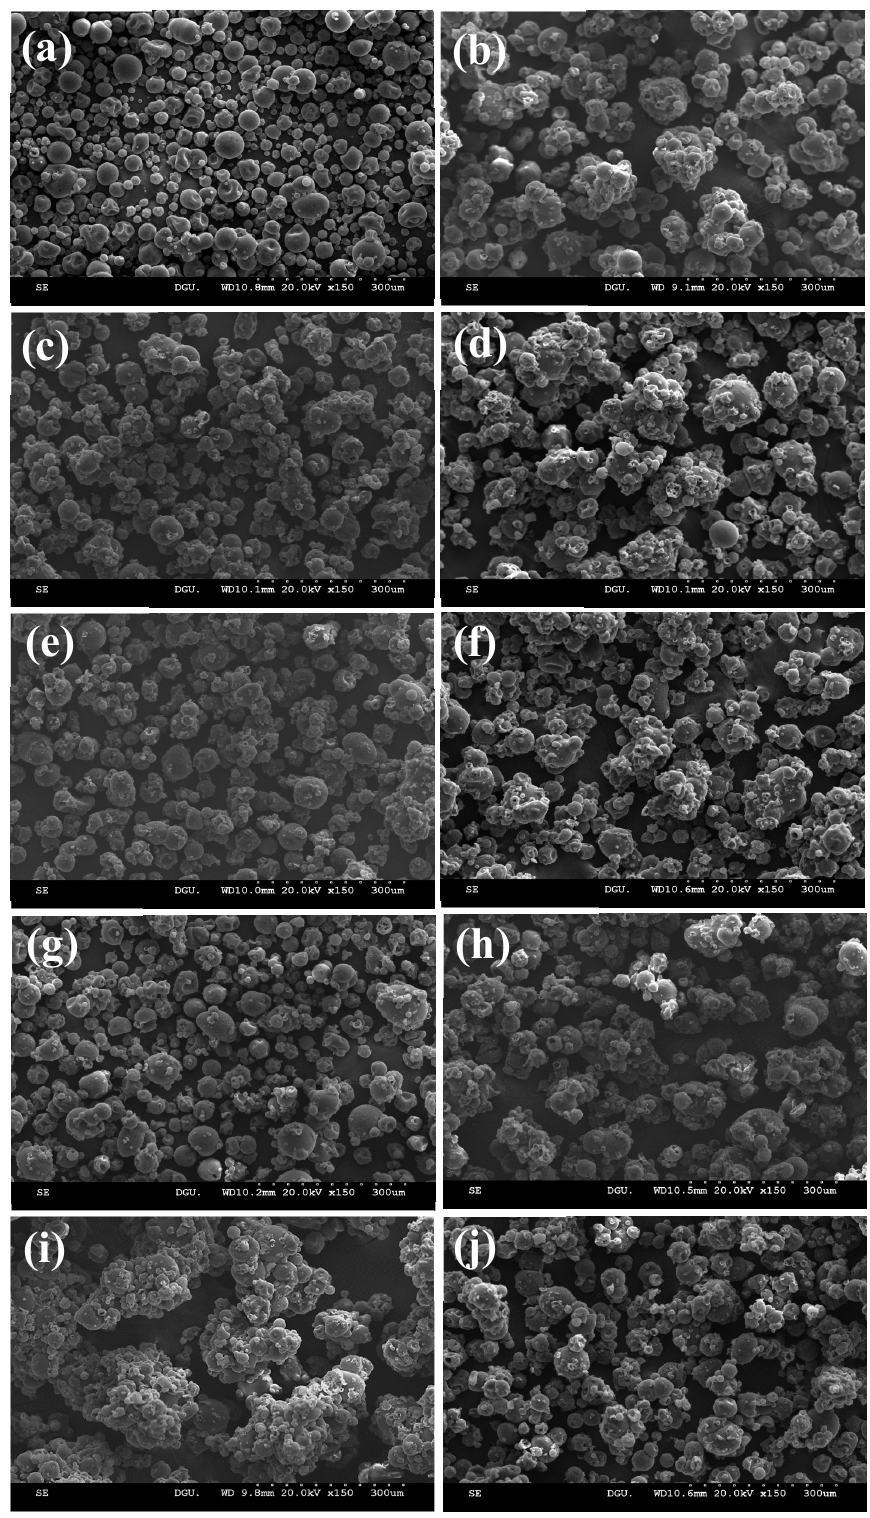
Figure 3. SEM micrographs of ( a ) raw and ( b – j ) agglomerated MPIPs with various sugar binders at different concentrations: ( b ) control (no sugar), ( c ) sucrose-10%, ( d ) sucrose-20%, ( e ) lactose-10%, ( f ) lactose-20%, ( g ) xylitol-10%, ( h ) xylitol-20%, ( i ) sorbitol-10%, ( j ) sorbitol-20%. Magnification 150×.